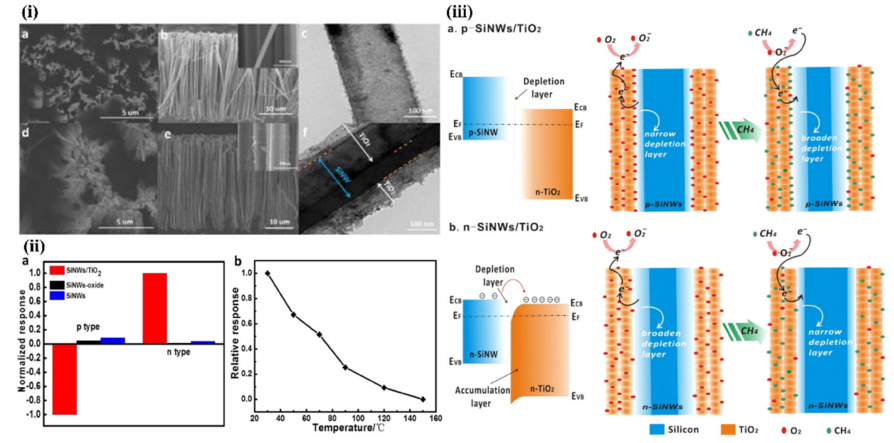
Figure 17. SiNWs / TiO 2 core-shell structures for CH 4 sensing: ( i ) SEM images of SiNWs before ( a , b ) and after ( d , e ) TiO 2 deposition and TEM images of SiNW ( c ) and SiNW / TiO 2 ( f ) structures; ( ii ) ( a ) n- and p-type SiNWs based sensors (bare, thermal oxidized and TiO 2 coated) responses to 100 ppm of CH 4 at RT, ( b ) the conductive response of n-SiNWs / TiO 2 sensor to 100 ppm of CH 4 at di ff erent temperatures.; ( iii ) schemes of RT CH 4 sensing mechanism for ( a ) p-SiNWs / TiO 2 , ( b ) n-SiNWs / TiO 2 Reproduced from [156], with permission from American Chemical Society,